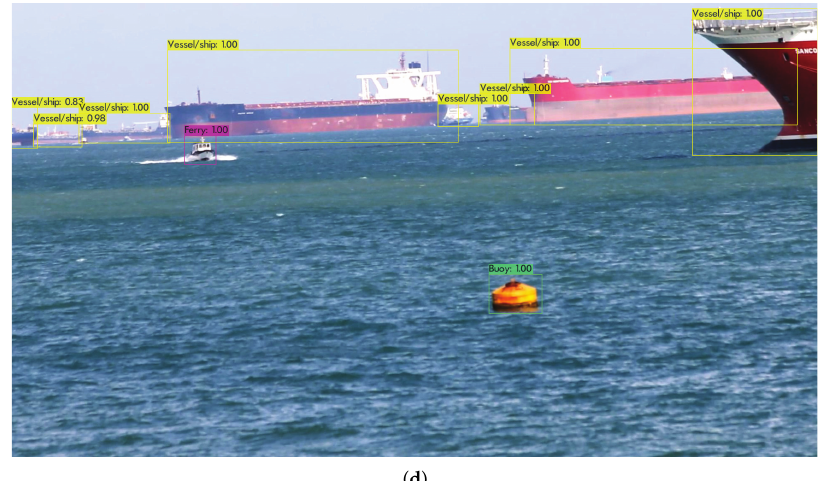
Figure 6. IoU for each recognition model. ( a ) Model 1. ( b ) Model 2. ( c ) Model 3. ( d ) Model 4. Figure 7 depicts a black-and-white marine image with four objects. The bounding box is placed in a non-object in Model 1 and one item is detected as two objects in Model 2. Model 3 does not detect objects hidden behind huge vessel/ship objects, while Model 4 does. Model 4 clearly outperforms other models in terms of object recognition in night images.